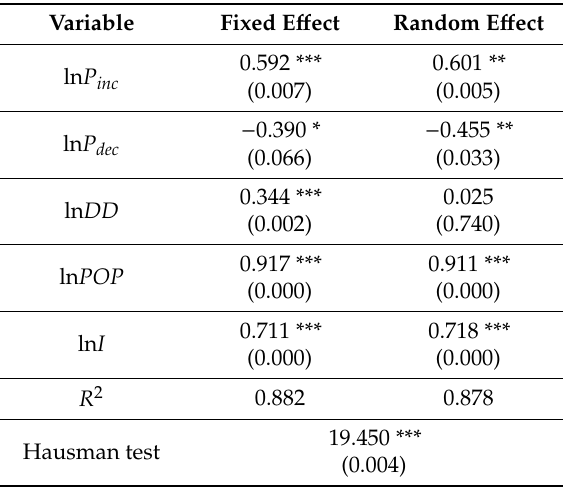
Table 2. Estimation results of static panel model.